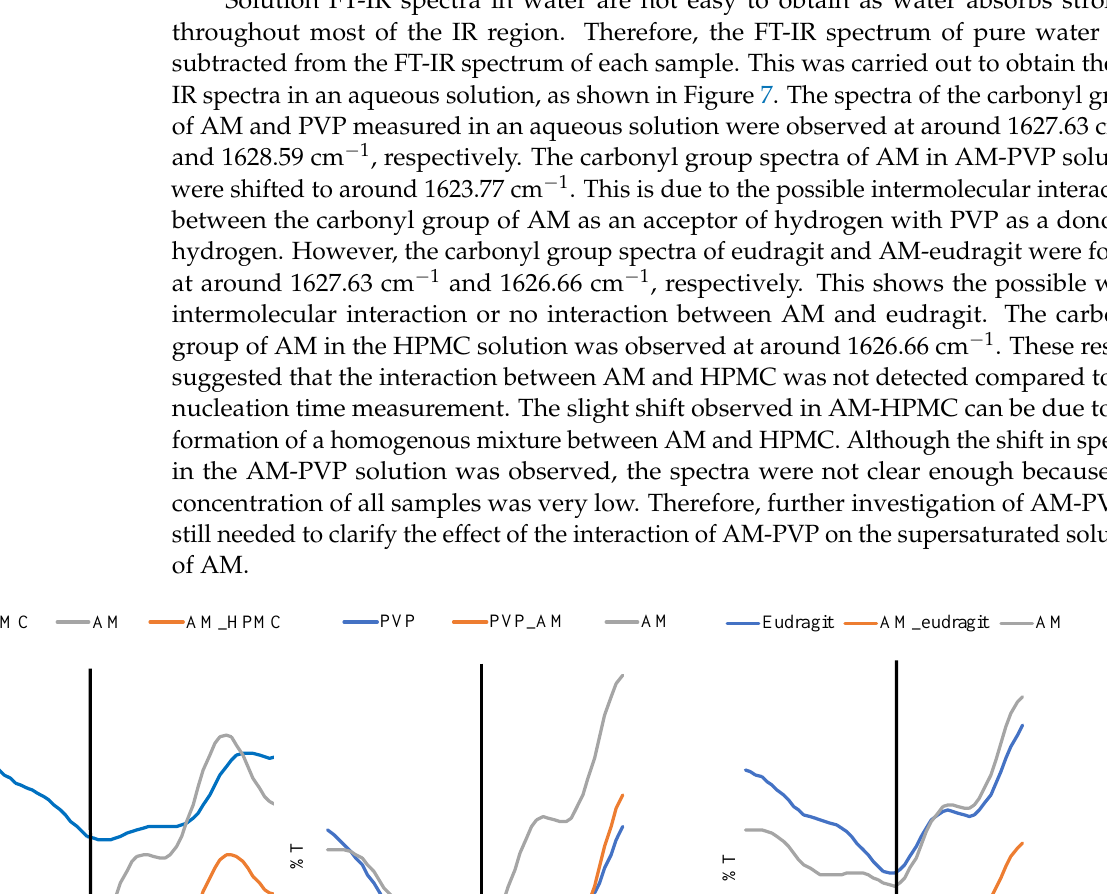
Table 1. Chemical shifts of proton PVP in the PVP solutions and the difference in the chemical shift compared to that in the buffer. Sample